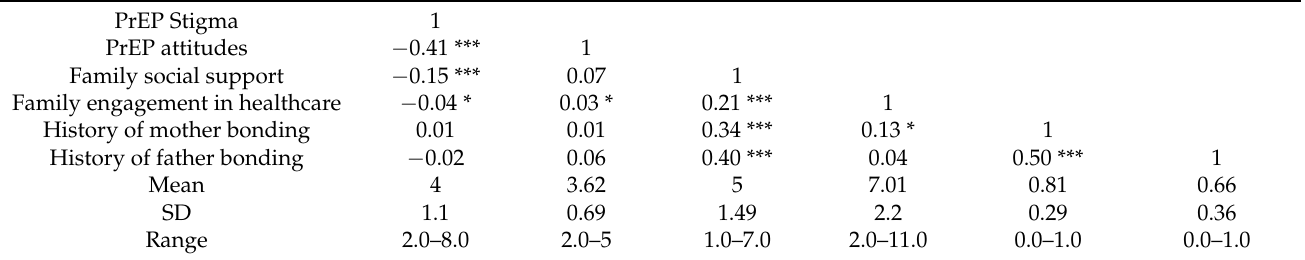
Table 2. Bivariate Correlations on PrEP Stigma ( n = 399).